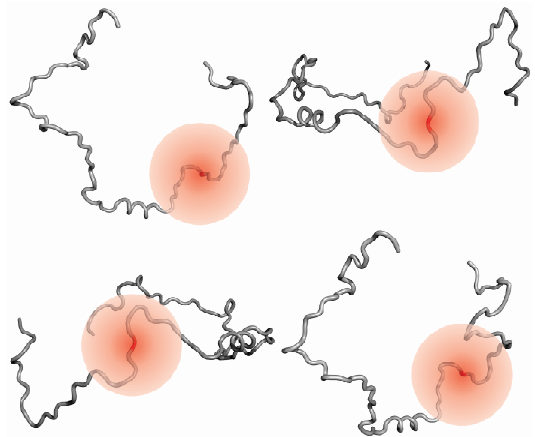
Figure 2. Paramagnetic probes for long-range contacts. If long-range contacts are present, residues sequentially distant from the tag will experience the PRE effect more frequently than would be expected from ideal random coil behavior. Different conformers will experience different PREs up to a range of 25Å as indicated by red